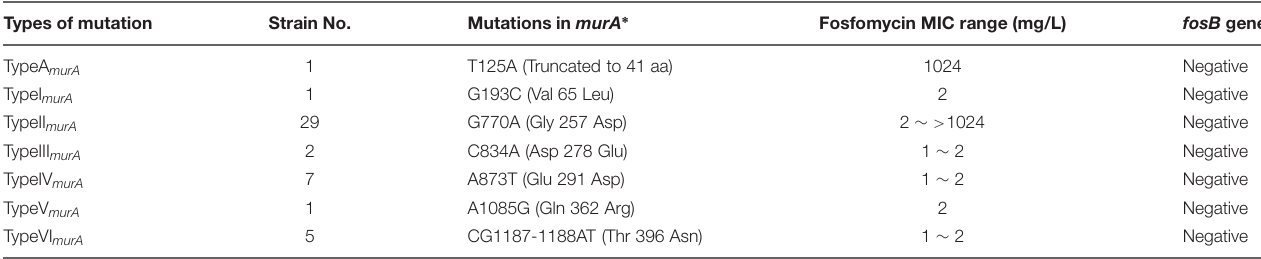
TABLE 3 | Characteristics of MRSA isolates contained murA